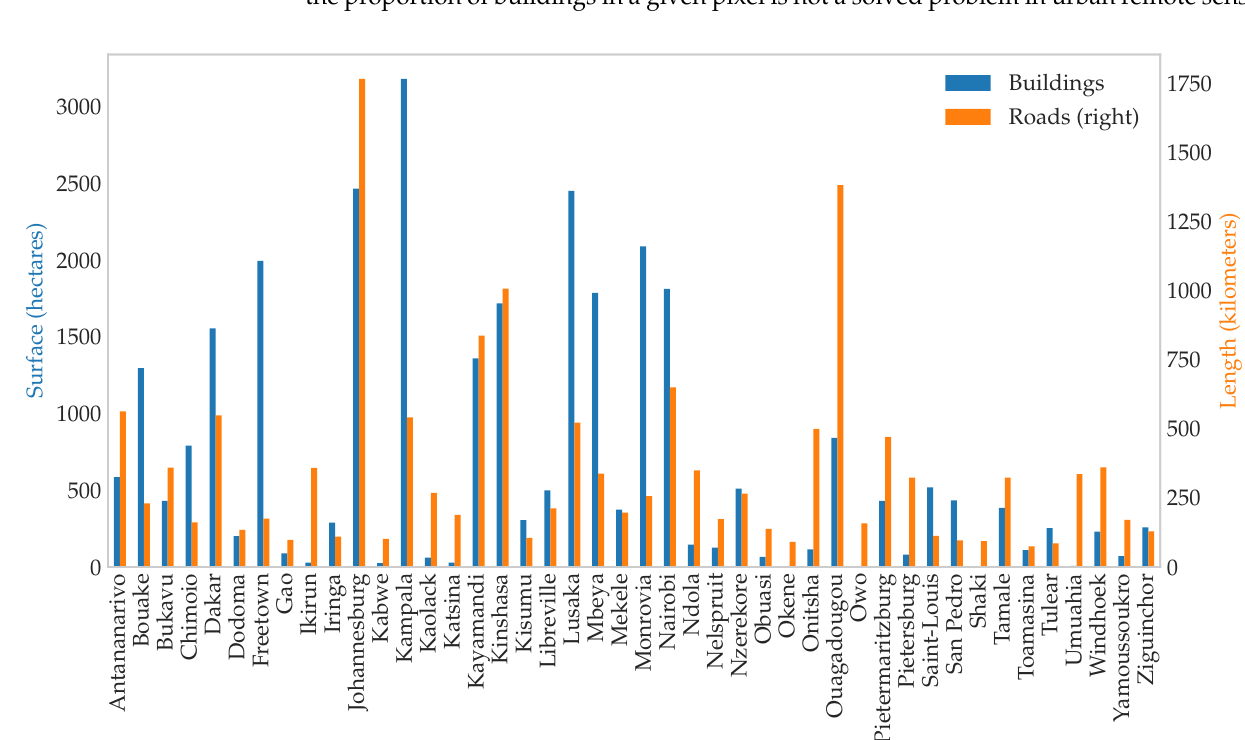
Figure 2. Availability of OpenStreetMap (OSM) building footprints (total surface in hectares) and roads (total length in kilometers) for each case study.